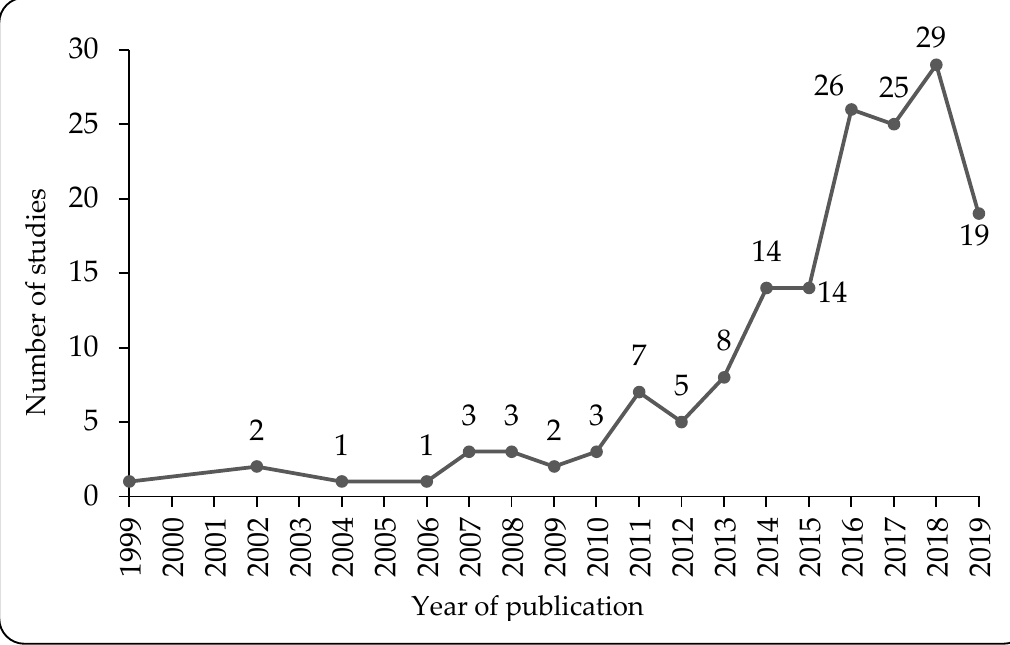
Figure 2. The number of studies on SB published per year (time to July 2019).